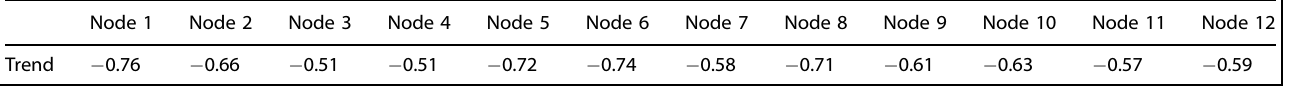
Table 3. Spatial correlation coef fi cients between the thermodynamic components (Fig. 6) and trends in surface air temperature (Fig. 10) for each